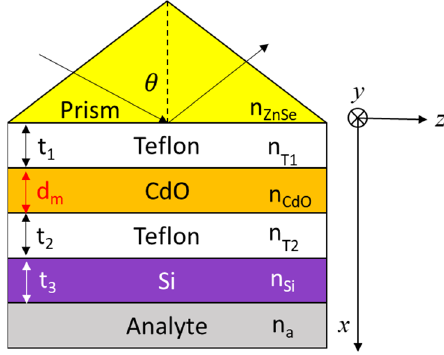
Figure 1. Schematic diagram of a hybrid waveguide-coupled CdO-based plasmonic sensor.